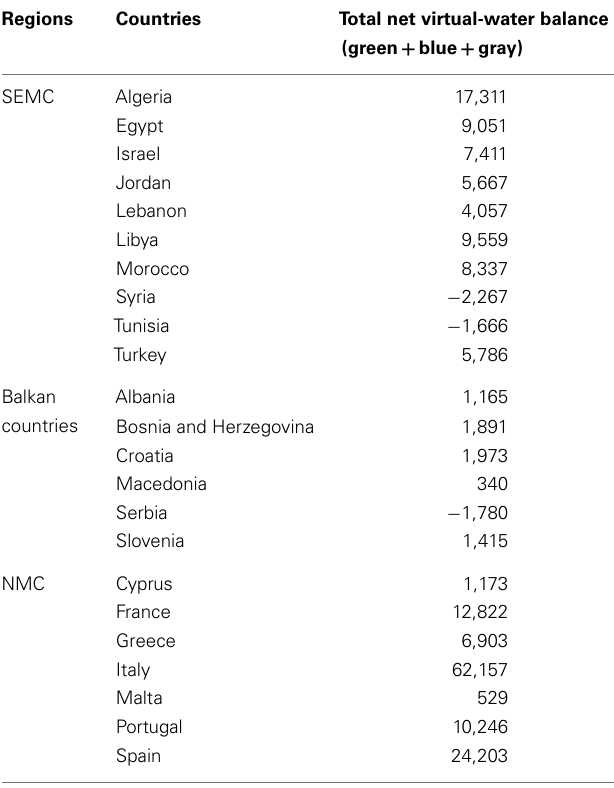
Table 2 | Net virtual-water balance (in million cubic meters per year)